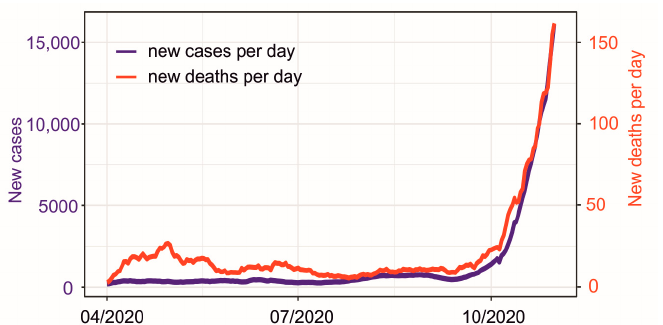
Figure 1. Daily new confirmed Coronavirus disease 2019 (COVID-19) cases (the blue color) and new deaths (the red color). The 7-day moving average is shown.